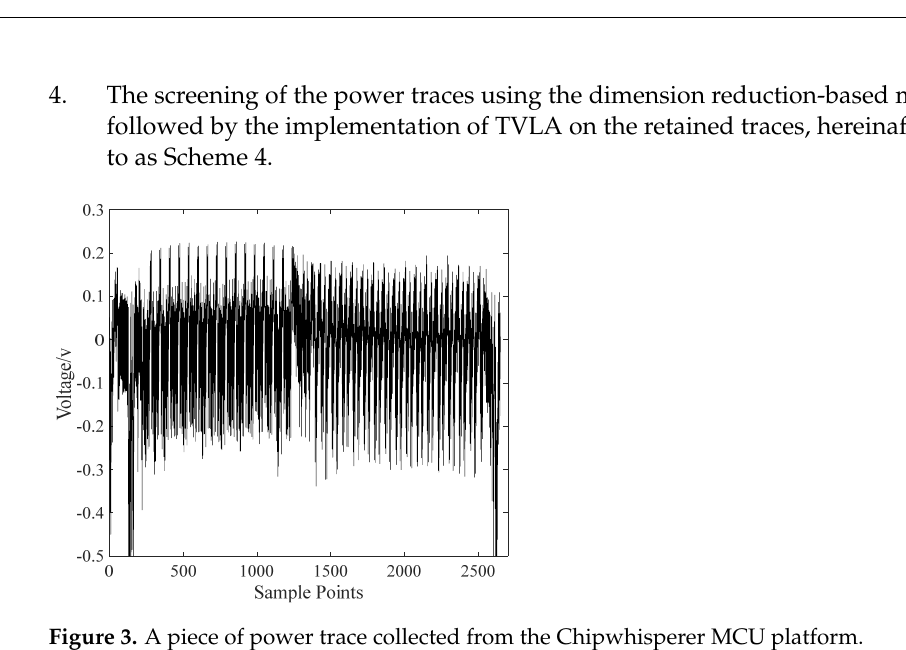
Figure 2. The connection of the power collection device.